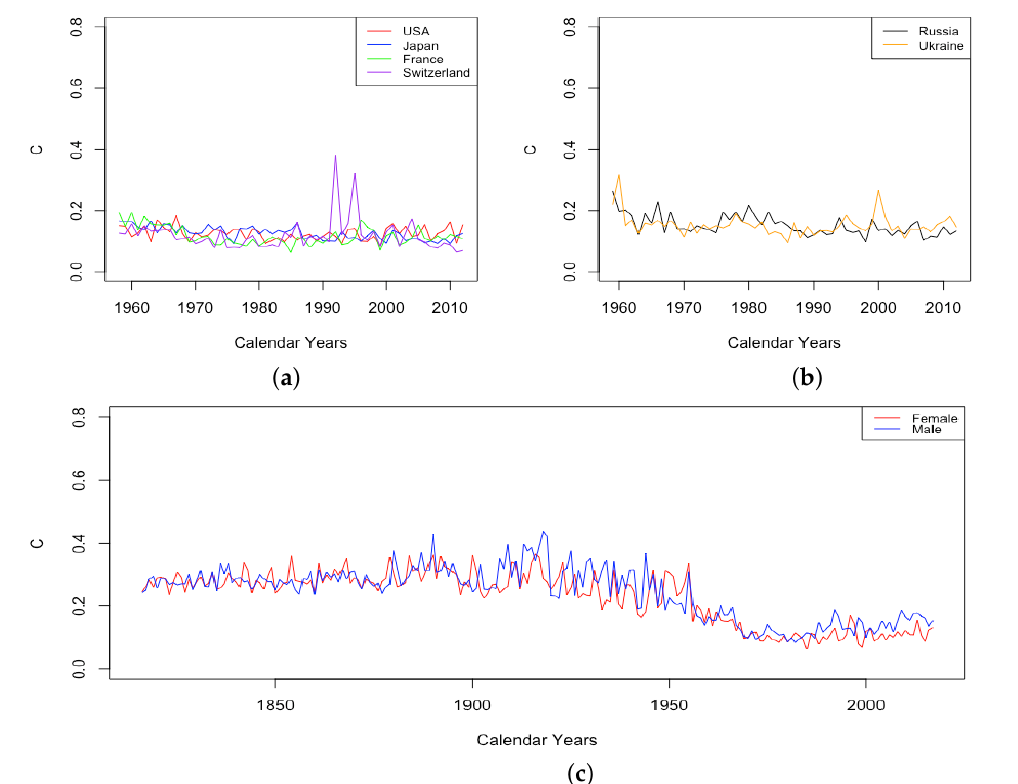
Figure 6. ( a ) Decline in mortality during childhood, i.e., C , across HLE countries. ( b ) Decline in mortality during childhood, i.e., C , across ILE countries. ( c ) Decline in mortality during childhood, i.e., C , for France civilian population, male vs.